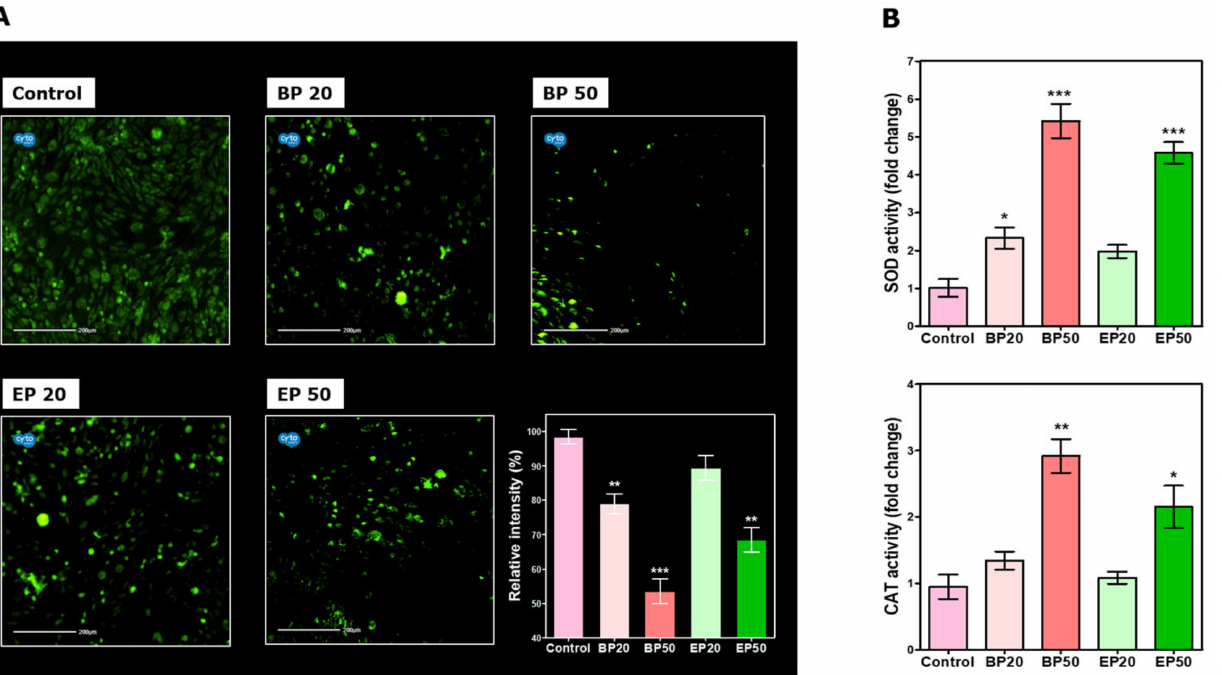
Figure 4. Redox imbalance caused by analogs BP and EP in Hep-2 cells. ( A ) Intracellular ROS production stained by DCF-DA captured by CytoSMART®Lux3 FL fluorescence microscope. ( B ) SOD and CAT enzyme activities. A decrease in ROS causes an imbalance in the redox status of the cancer cells, causing the induction of apoptosis. Data are expressed as mean ± SD of three independent experiments. * p < 0.05, ** p < 0.01, *** p < 0.001 significance difference between the control and treatment. Scale: 200 µ